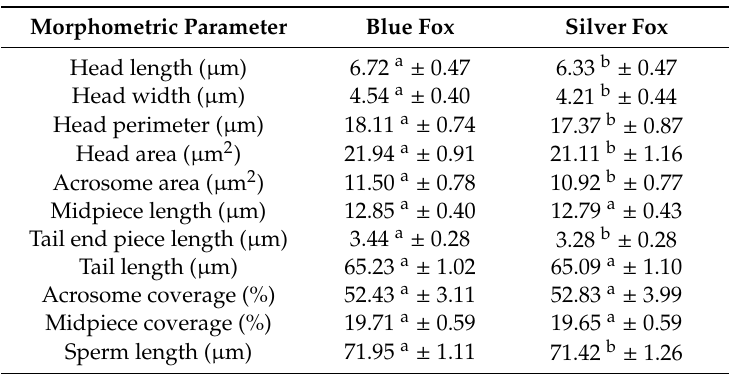
Table 2. Morphometric parameters of fox sperm measured manually with Multiscan software. Di ff erent superscript letters designate significant di ff erences between means within rows at p ≤ 0.05 (mean ± standard